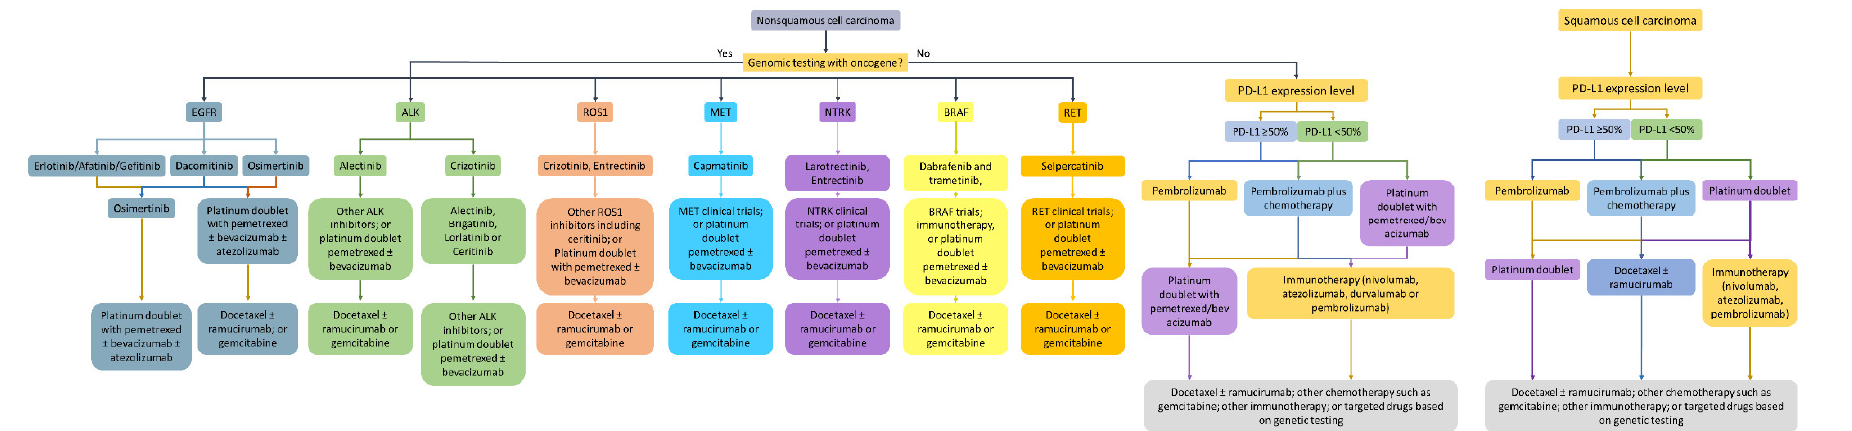
Figure 1. Genomic-informed and immunotherapy-focused management of NSCLC based on approved therapies. The role of immunotherapy is not clear in all of the actionable targets but is currently under investigation.